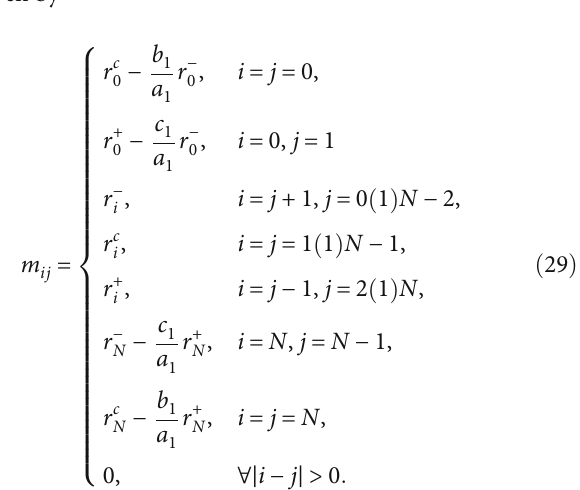
Table 1: Values of E